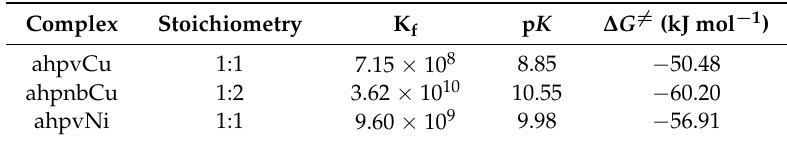
Table 1. Formation constant (K f ), stability constant (p K ), and Gibbs free energy ( ∆ G (cid:54) = ) values of the synthesized complexes in aqueous ethanol at 298